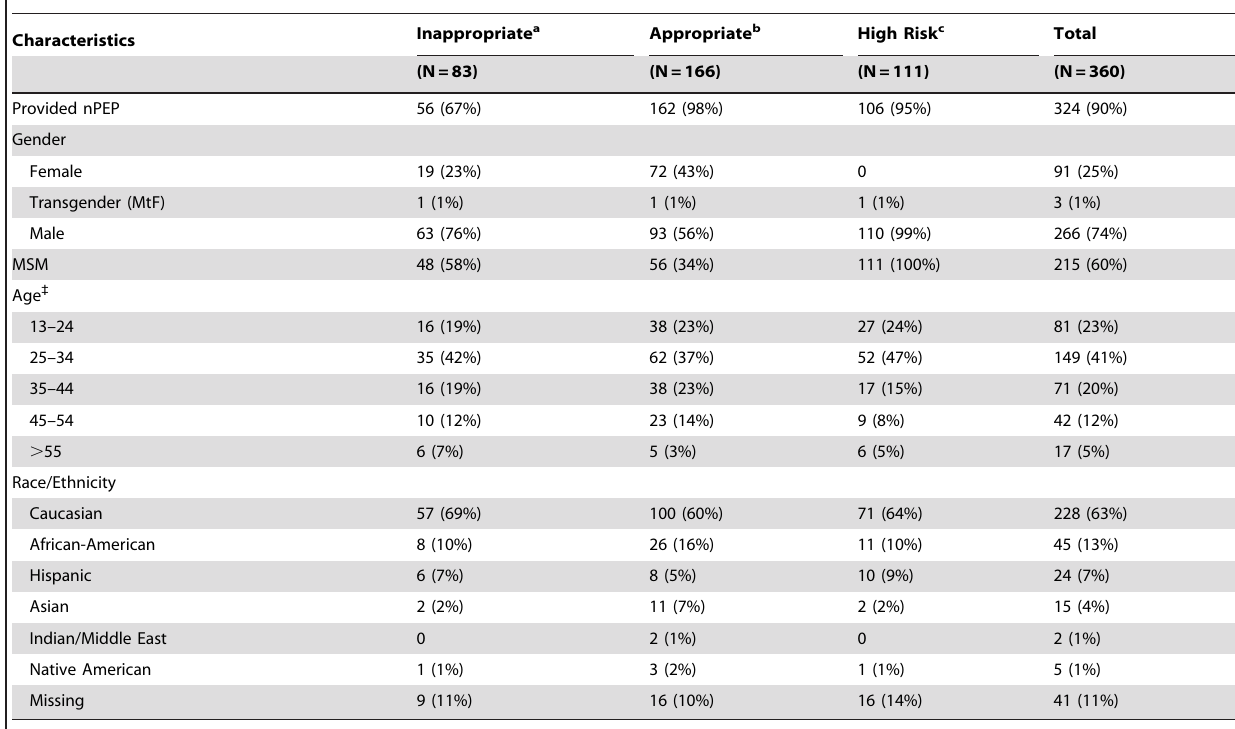
Table 1. Presentations for nPEP by exposure risk level. {